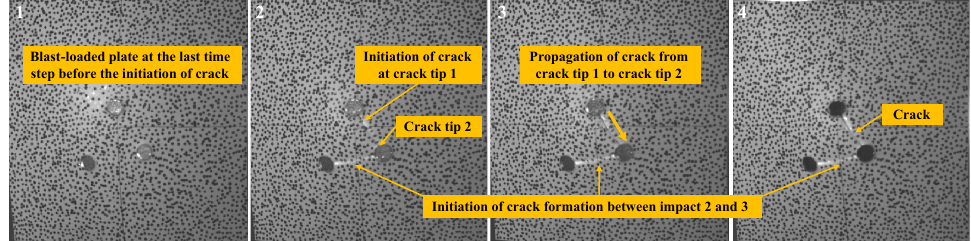
Figure 19. Image of the final state after blast loading for the plate experiencing cracking (configuration 4). The spray-painted speckle pattern area is shown with a zoom-in on the three enlarged holes. The zoomed image shows the location of crack tips and crack propagation between the first and the third hole. The figure also shows a plane view of the permanent deformation of the blast-loaded aluminum plate.